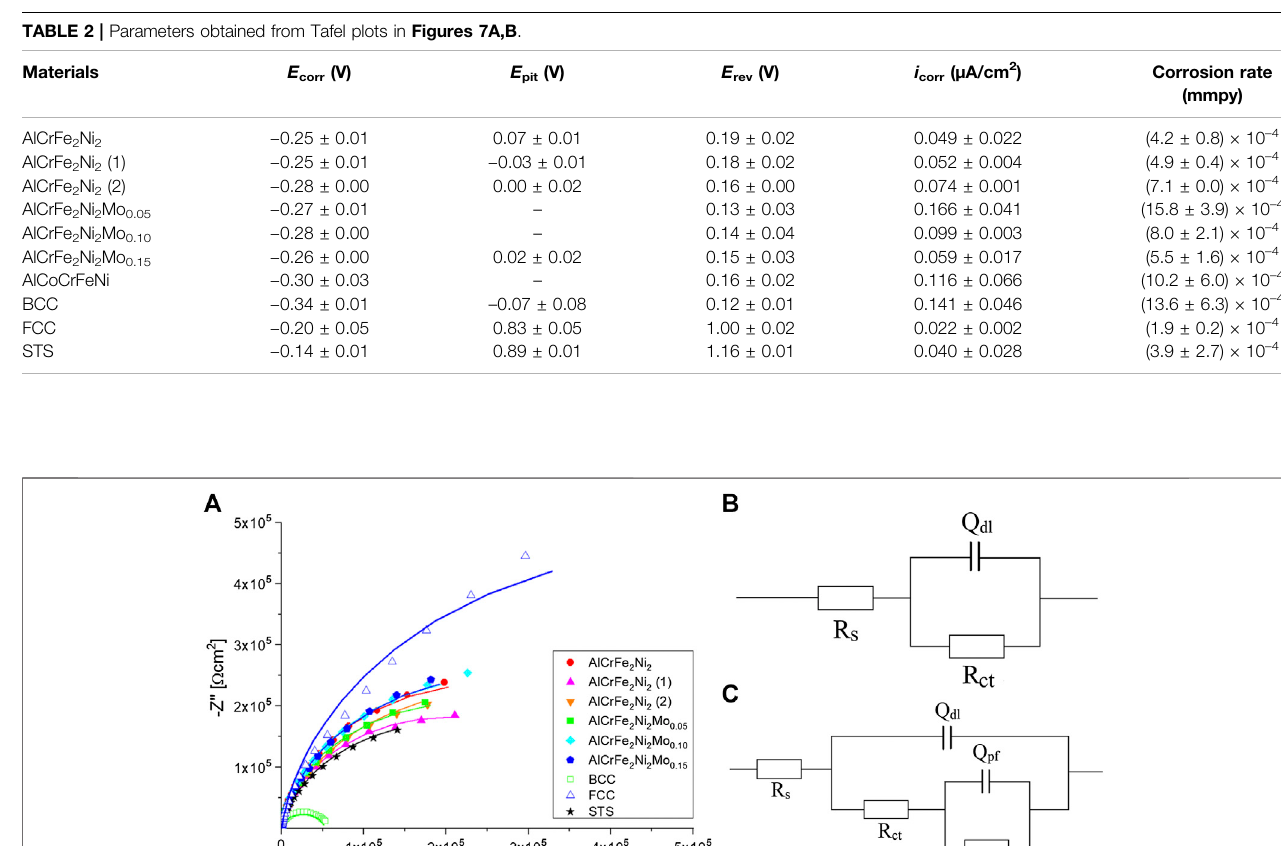
TABLE 2 | Parameters obtained from Tafel plots in Figures 7A,B .